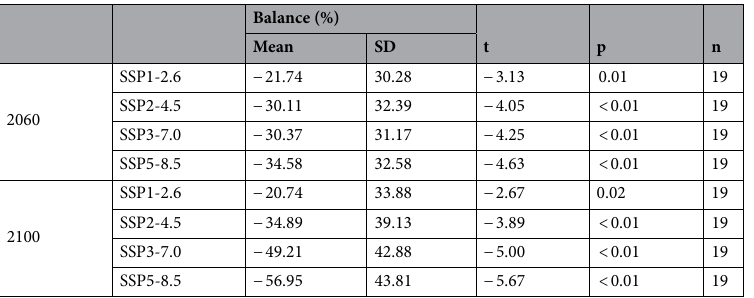
Table 1. t-tests to evaluate if the balance in the distribution area was different from zero. Balance (%) is the difference between area gain and area loss predicted and is proportional to the current distribution area for Atlantic Forest endemic primate species (n = 19). Negative values indicate reduction in distribution size predicted for the future. Projections for all Shared Socioeconomic Pathways (SSP1-2.6, the most optimistic